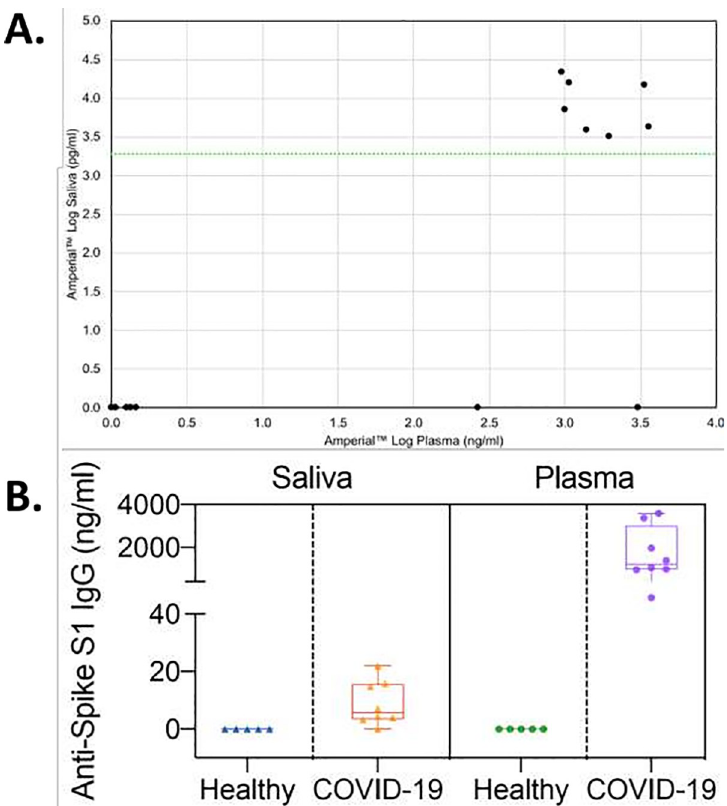
Fig 10. Relationship of plasma anti-SARS-CoV-2 IgG levels to saliva levels measured by Amperial ™ assays. (A) Panel A shows a log / log plot of plasma versus saliva levels showing a clustering of the positive values with high plasma levels associated with high saliva levels on the Amperial ™ platform. (B) Box plot of COVID-19 (n = 8) and healthy (n = 5) subjects demonstrating that the normalized plasma levels are approximately 50X those of saliva.